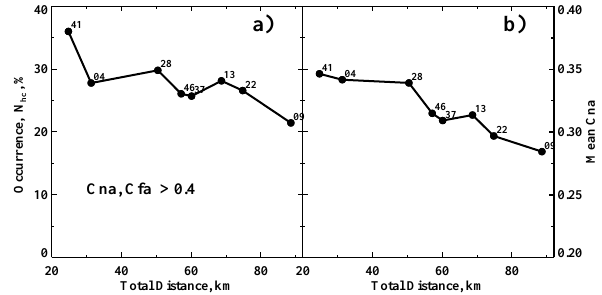
Fig. 7. Dependence of the (a) occurrence of HCPs and (b) mean correlation coefficient C na upon the total distance between the col- lecting area foci for selected IRIS beams. The IRIS beam numbers are shown by digits near each